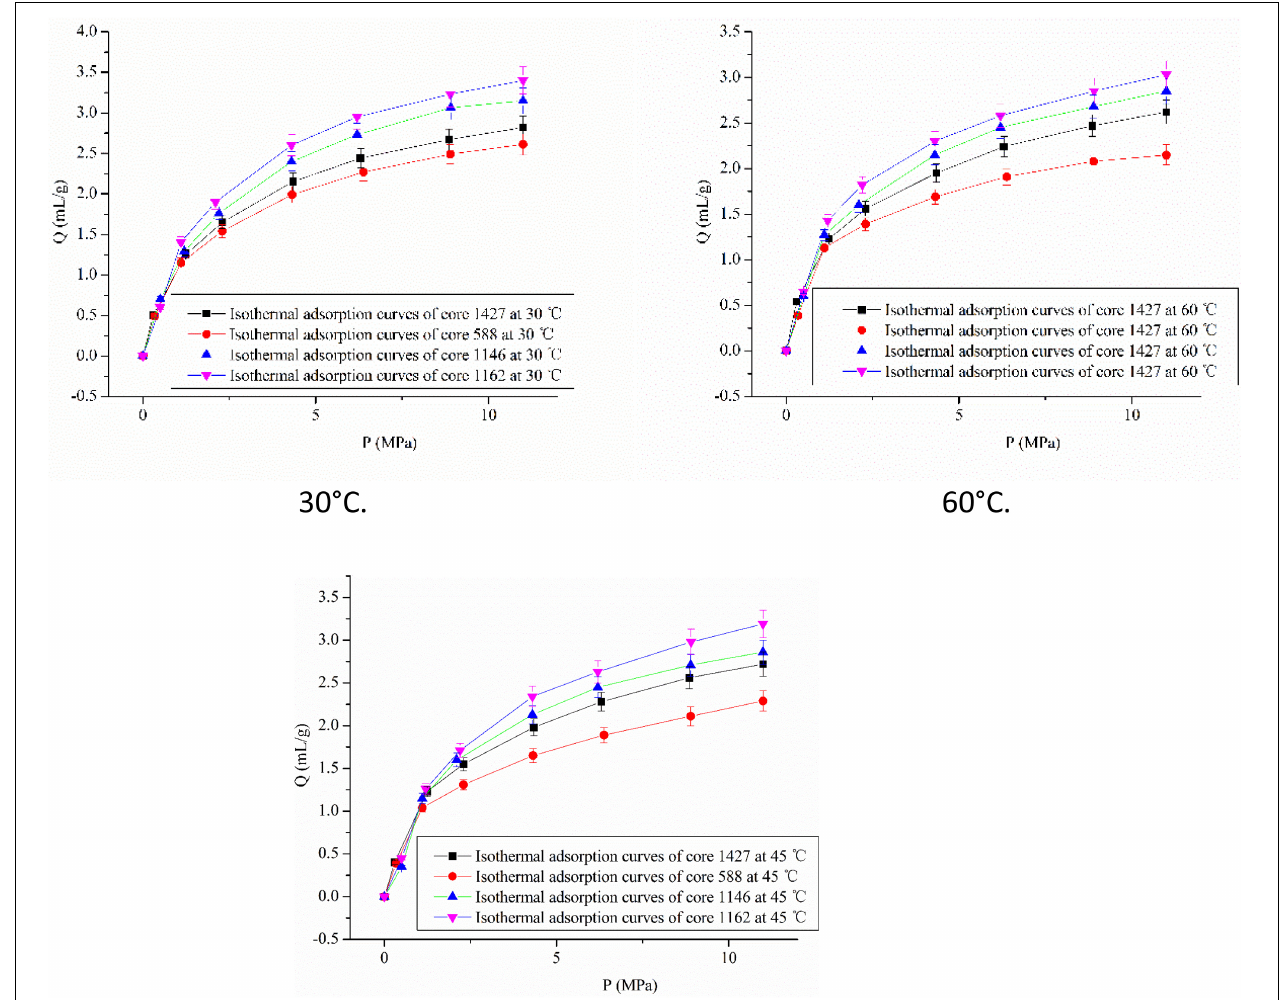
FIGURE 6 | Isothermal adsorption curve of samples at 30, 45, 60 ◦ C from eastern Sichuan